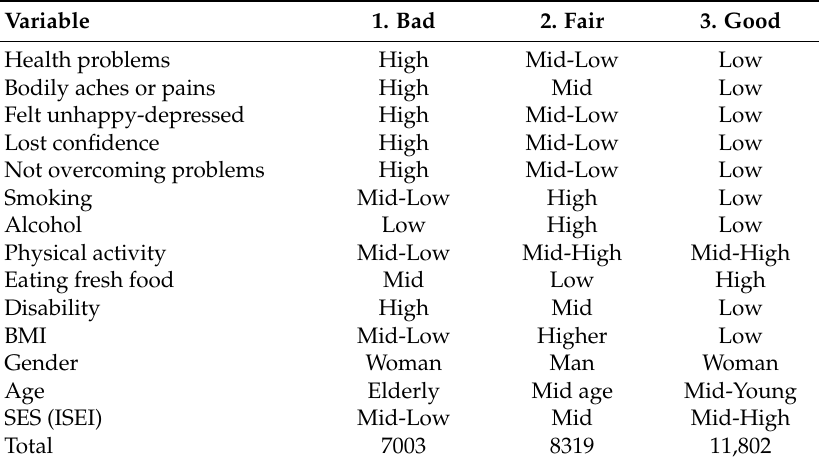
Table 3. Description of cluster analysis